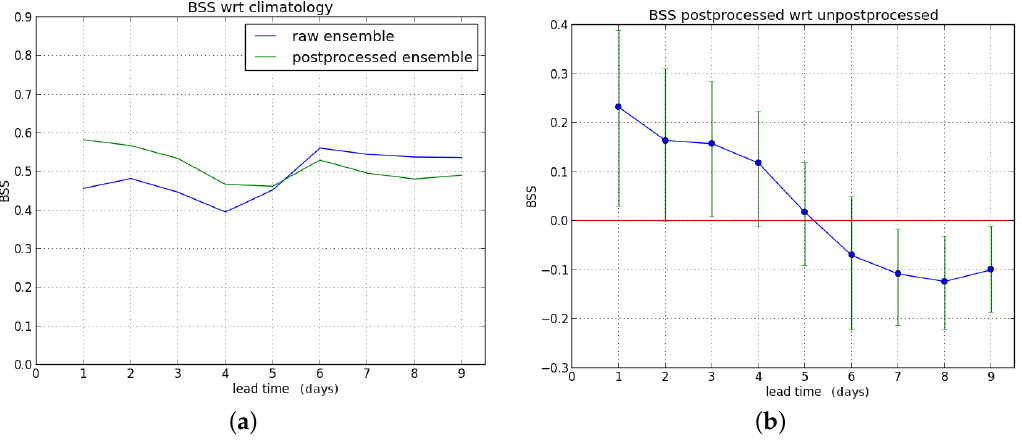
Figure 5. Brier Skill Score for P90 threshold during hydrological winter. ( a ) Compared to sample climatology; ( b ) Improvement due to postprocessing.